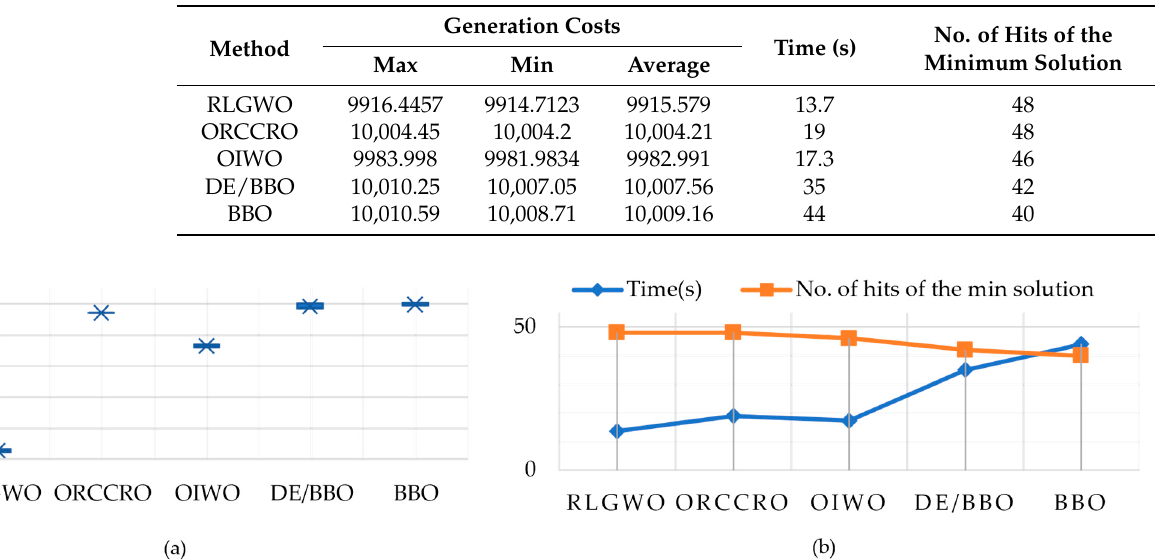
Table 10. Comparison between different methods taken after 50 trials (160-unit system).